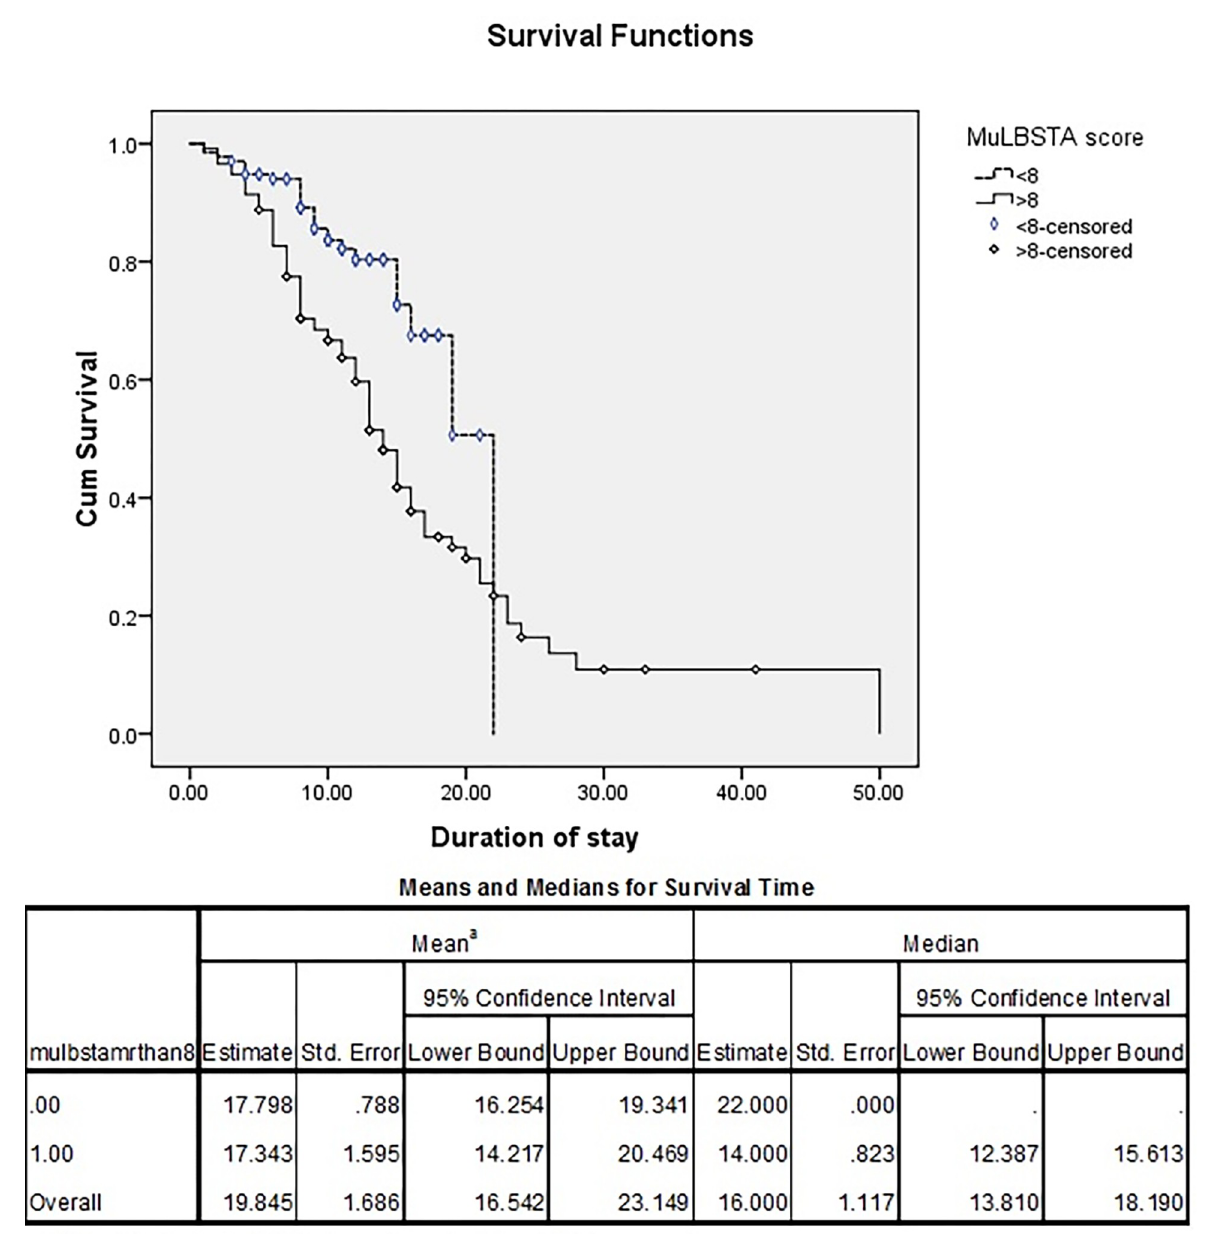
Fig 4. Kaplan-Meier curve of comparison of MuLBSTA score of < 8 with >